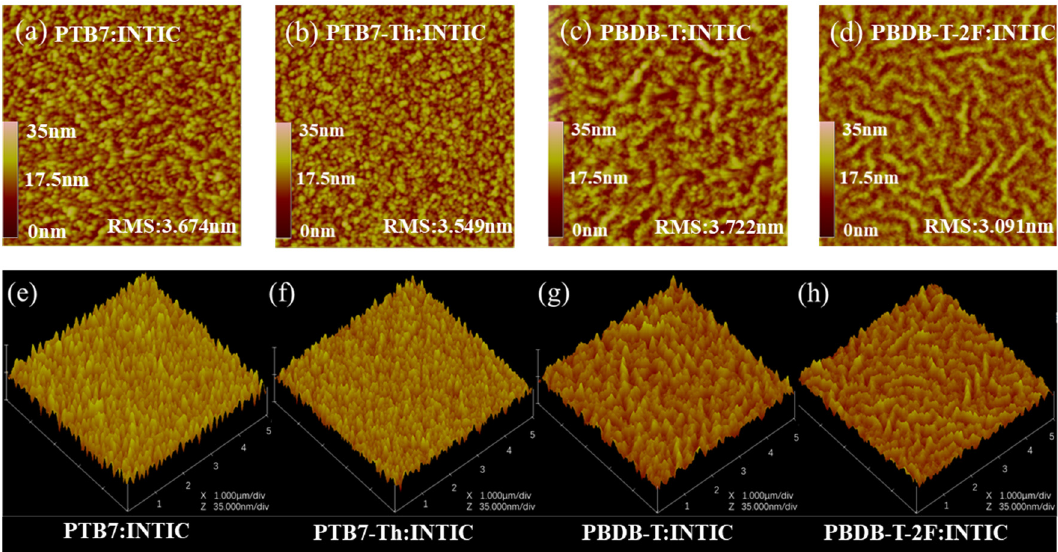
Figure 4. AFM images of the active layer with ( a and e ) PTB7:INTIC; ( b and f ) PTB7-Th:INTIC; ( c and g ) PBDB-T:INTIC; ( d and h ) PBDB-T-2F:INTIC.